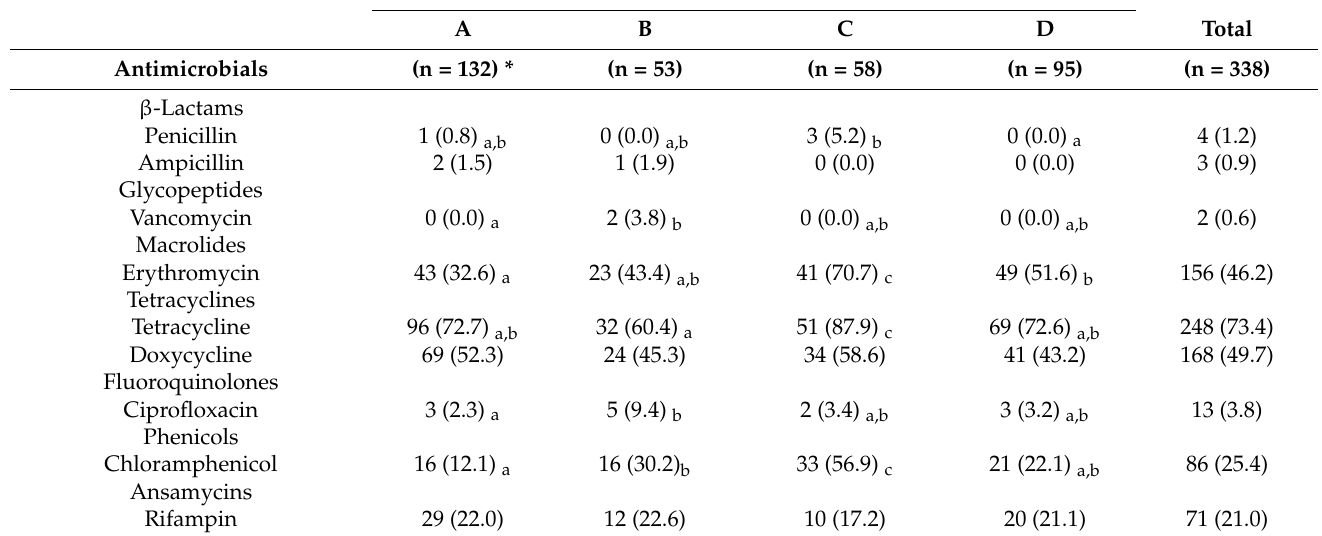
Table 1. Antimicrobial resistance of Enterococcus faecalis and Enterococcus faecium in bulk tank milk samples from four dairy companies.